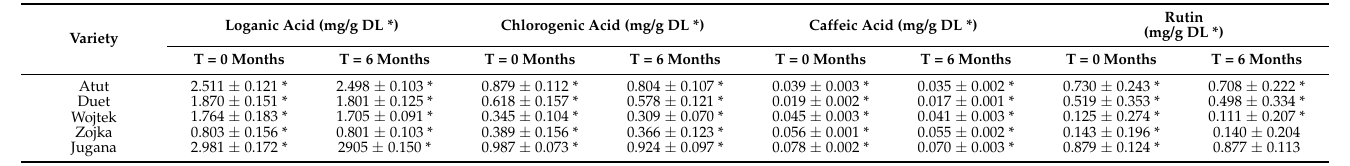
Table 3. Results of the content of active substances by HPLC for haskap berry leaves in T = 0 and T = 6